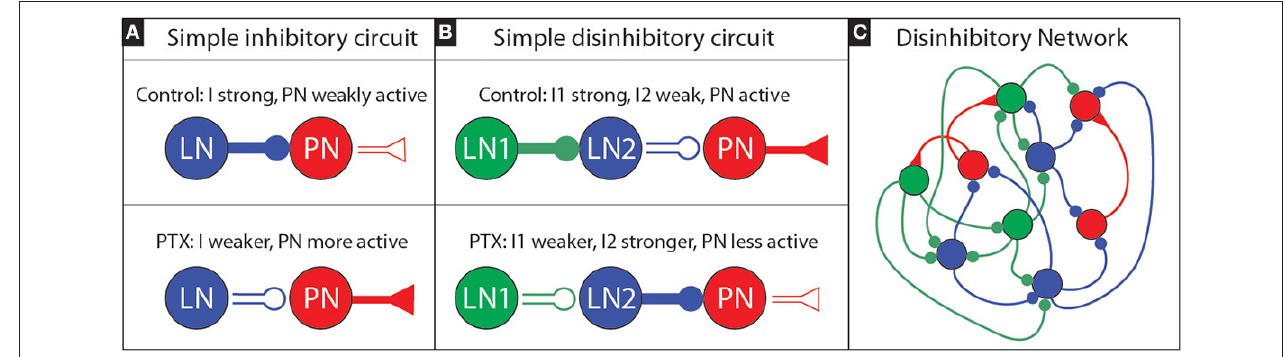
FIGURE 8 | Sketch of an inhibitory and disinhibitory circuit, as well as a more realistic disinhibitory network: (A) We illustrate a simple inhibitory circuit, involving a single LN which produces presynaptic inhibitory current I that inhibits a single PN. Under PTX we expect the efficacy of inhibitory synapses to decrease; thus I should get smaller, implying that the PN activity will increase. (B) We illustrate a simple disinhibitory circuit, involving an LN1 which produces a presynaptic inhibitory current I1 that inhibits another LN2. This LN2, in turn, produces a presynaptic inhibitory current I2 that inhibits a single PN. If the activity level of the first LN1 is high, we may expect LN2 to be only weakly active, and for the PN to be active. Under PTX we expect that the efficacy of inhibitory synapses will decrease: as a result I1 will decrease, and so the activity level of LN2 will increase. This increased activity level—combined with the now decreased efficacy of inhibitory synapses—will alter I2. If the activity level increase of LN2 is sufficiently large, it is possible for I2 to actually increase overall (even though PTX has been applied). As a consequence, it is possible for the PN activity level to actually decrease overall—even though PTX has been applied. (C) A more realistic disinhibitory network would involve not just three neurons, but rather a collection of LNs and PNs, with the former heterogeneously coupled. In the heterogeneous network shown we have colored the various LNs according to the role they might play with regards to disinhibition: those LNs that predominantly inhibit PNs are classified as “LN2s” and colored blue, while the LNs that predominantly inhibit the LN2s are classified as “LN1s” and colored green. In reality the roles are not so clear cut; some LNs will both inhibit PNs as well as inhibit other LNs, and it may not always be possible to clearly classify each and every LN into a specific